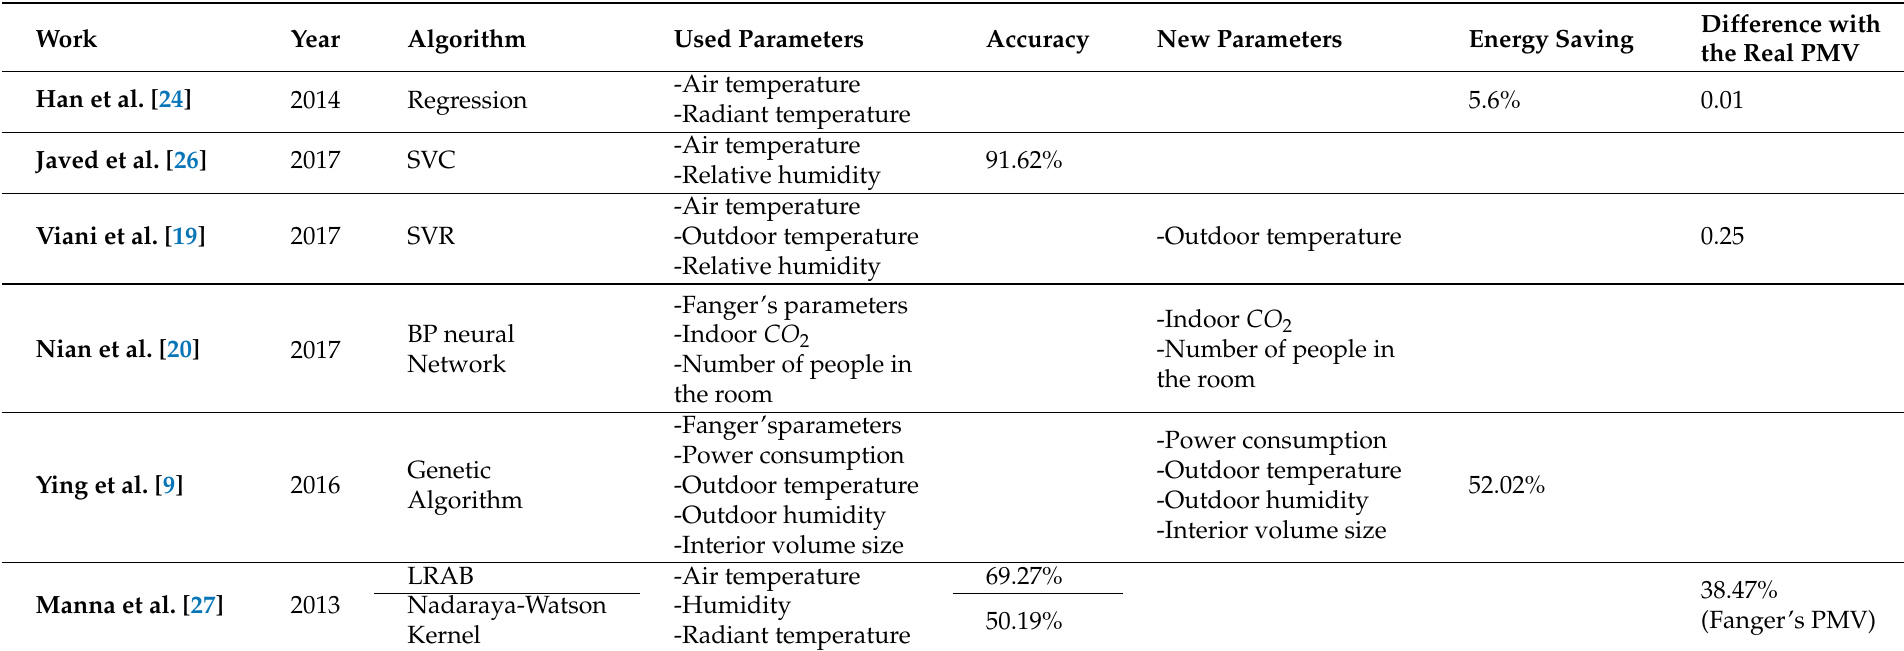
Table 3. Comparative table of the Related